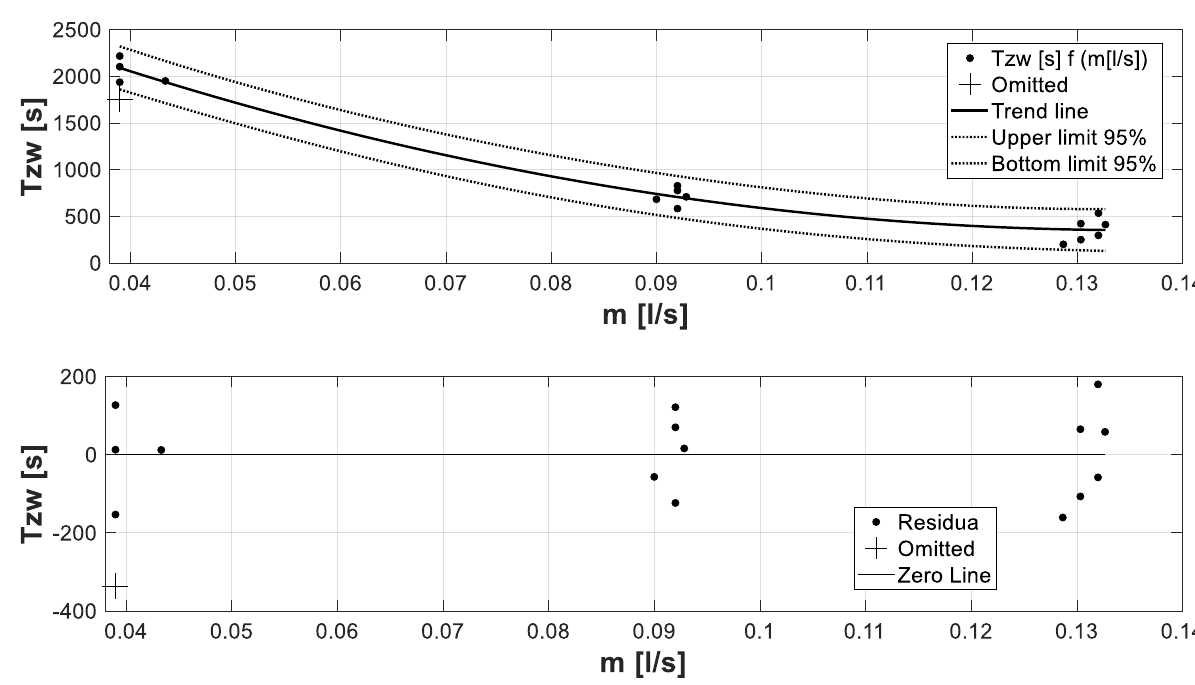
Figure 13. Impact of the circulator pump output on the value of the time constant of the heat exchanger.